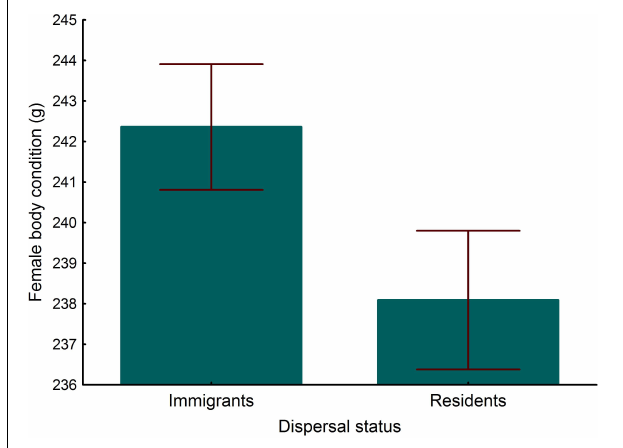
FIGURE 3 | Differences in body condition (body mass corrected by tarsus length) between immigrant and resident breeding females. Bars and whiskers represent mean and s.e. values,